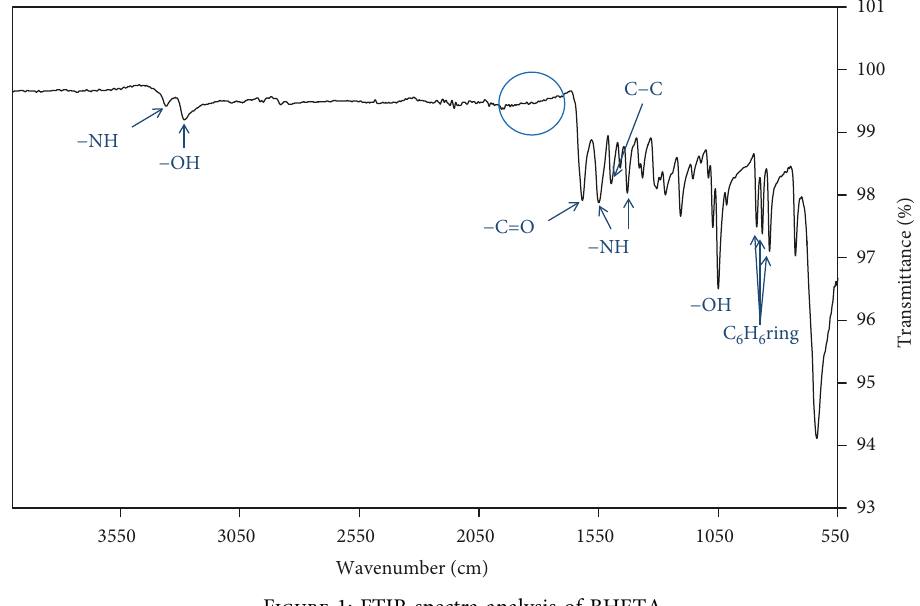
Figure 1: FTIR spectra analysis of